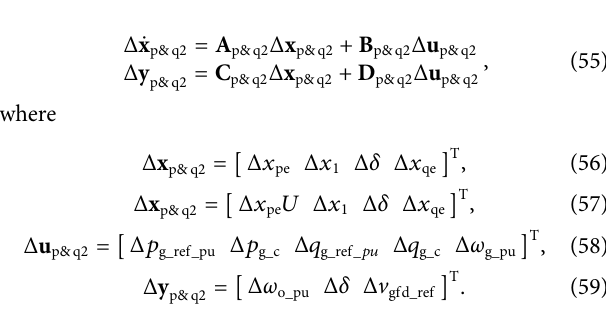
( s ) with and without the lead open